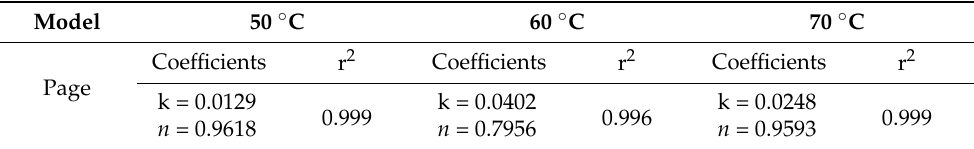
Figure 1. Experimental evolution and the predicted moisture ratio of jackfruit seeds’ flour with drying times at 50, 60 and 70 ◦ C. Table 1. Coefficients obtained from the Page model according to experimental data evaluated at different